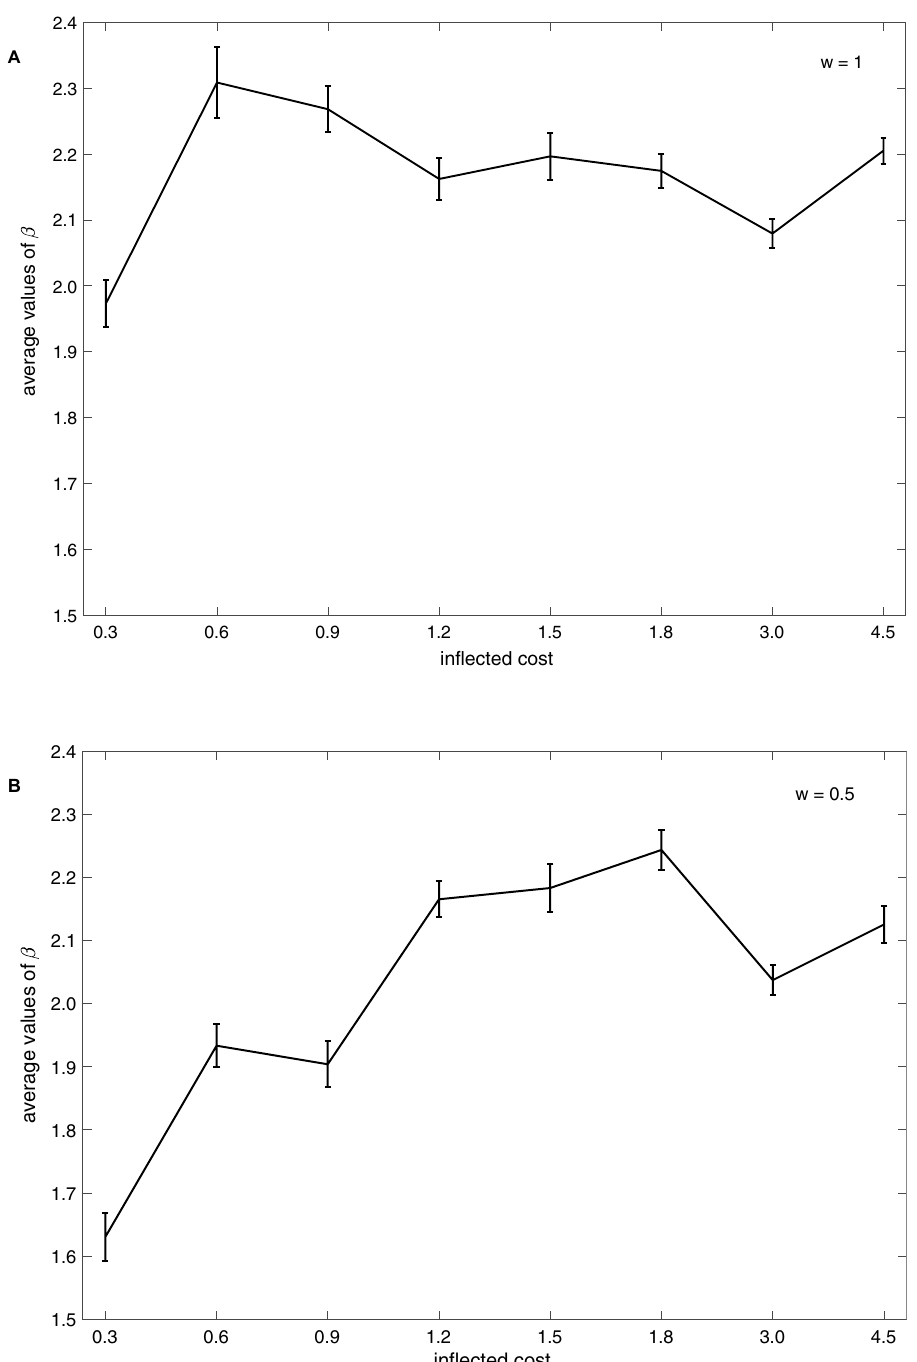
Figure 5. Population average β values for various costs in the 20,000th generation. ( A ) ( w ) = 1 and ( B ) ( w ) =